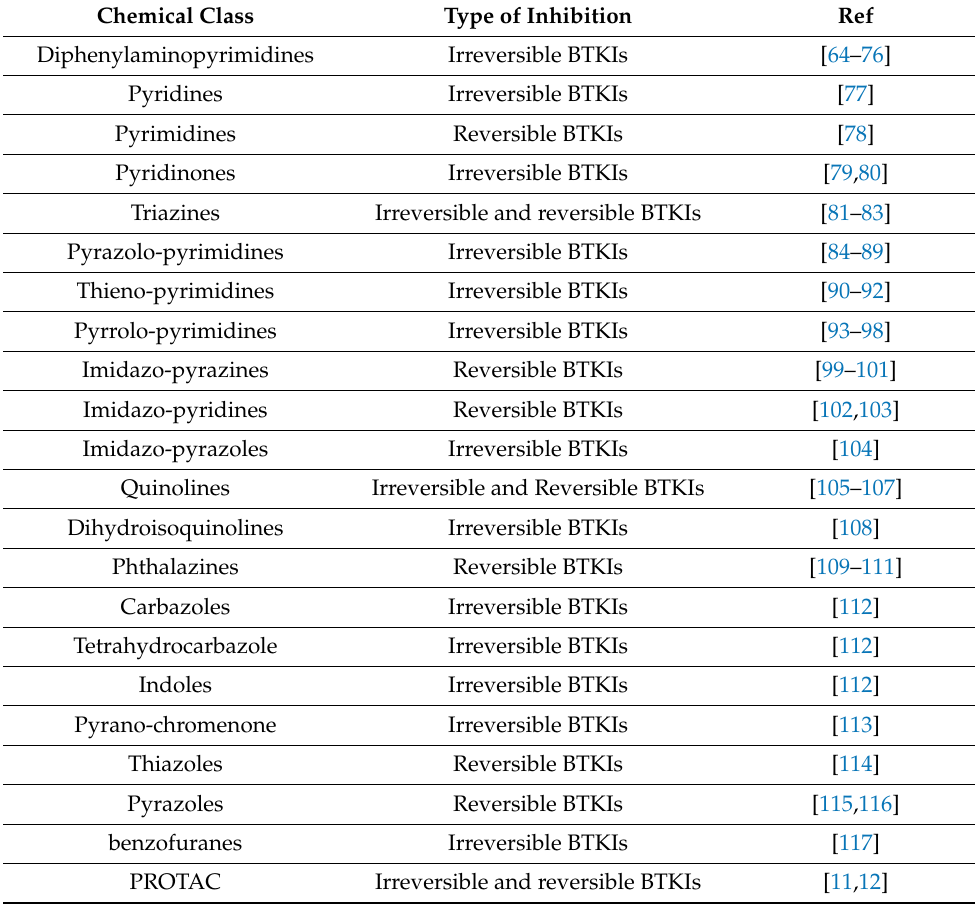
Table 4. Chemical class of (ir)reversible BTKIs reported in literature from 2017 to date and corre- sponding